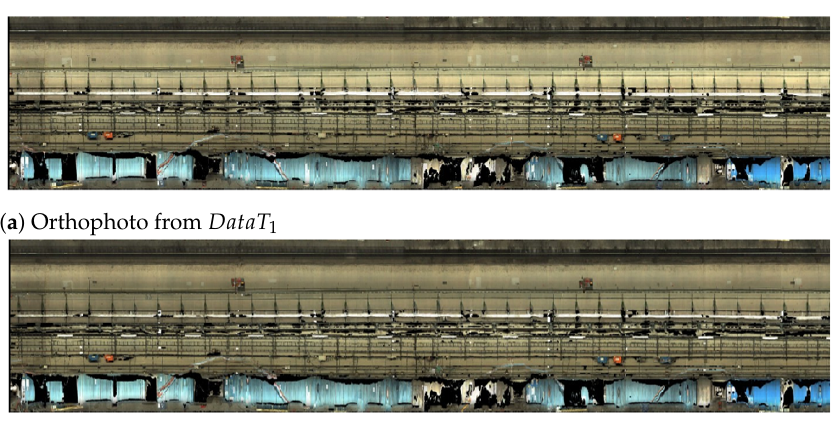
Figure 3. Orthophotos generated from DataT 1 ( a ) and DataT 2 ( b ) captured during the demo